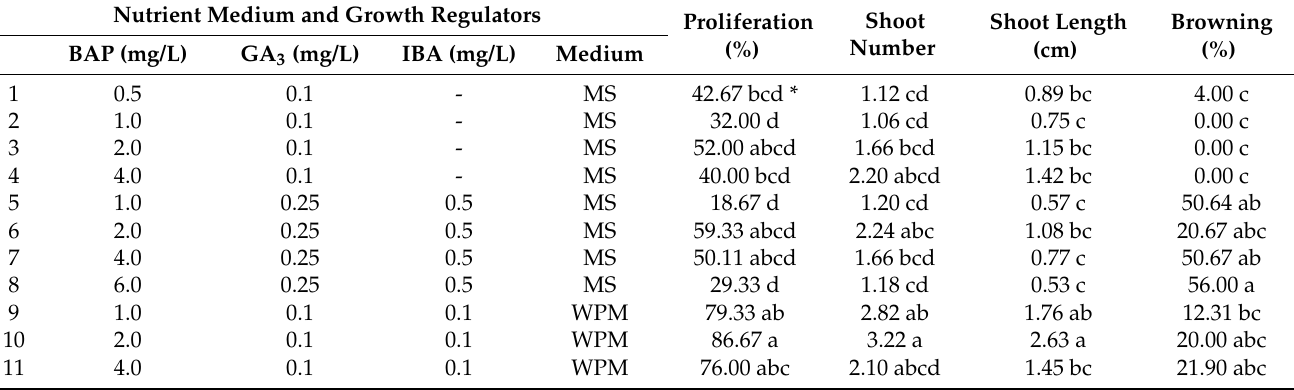
Table 4. Effect of growth hormones on the percentages of explants responding, surviving, browning, and proliferating, as well as their effect on the shoot number and shoot length of